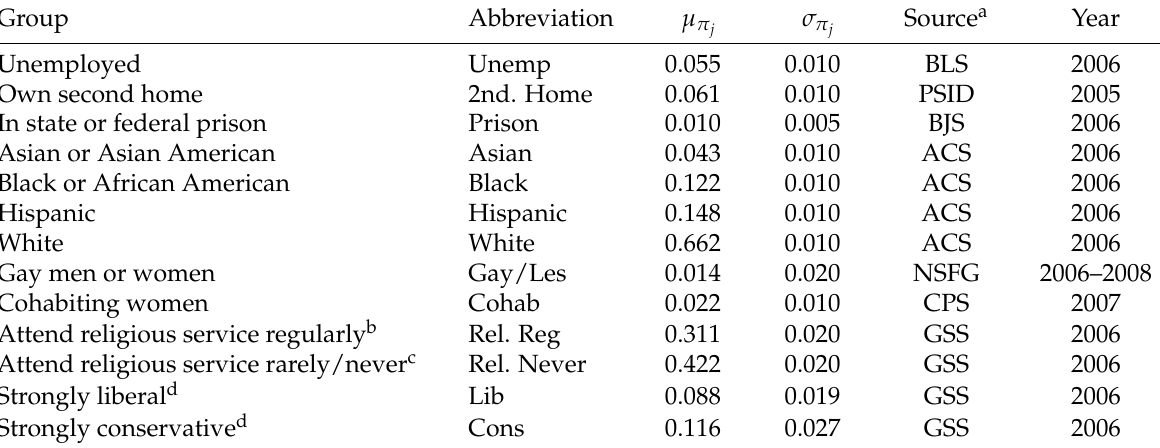
Table 1: Prior means, scale parameters, and data sources of population shares of analyzed social